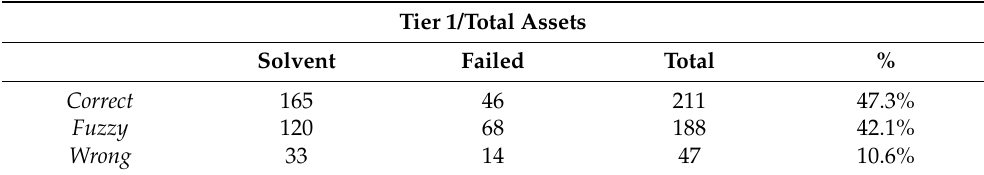
Table 4. The efficiency of the Tier1/Total Assets based network.